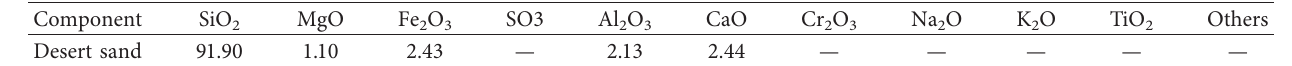
Table 5: Chemical composition of desert sand.